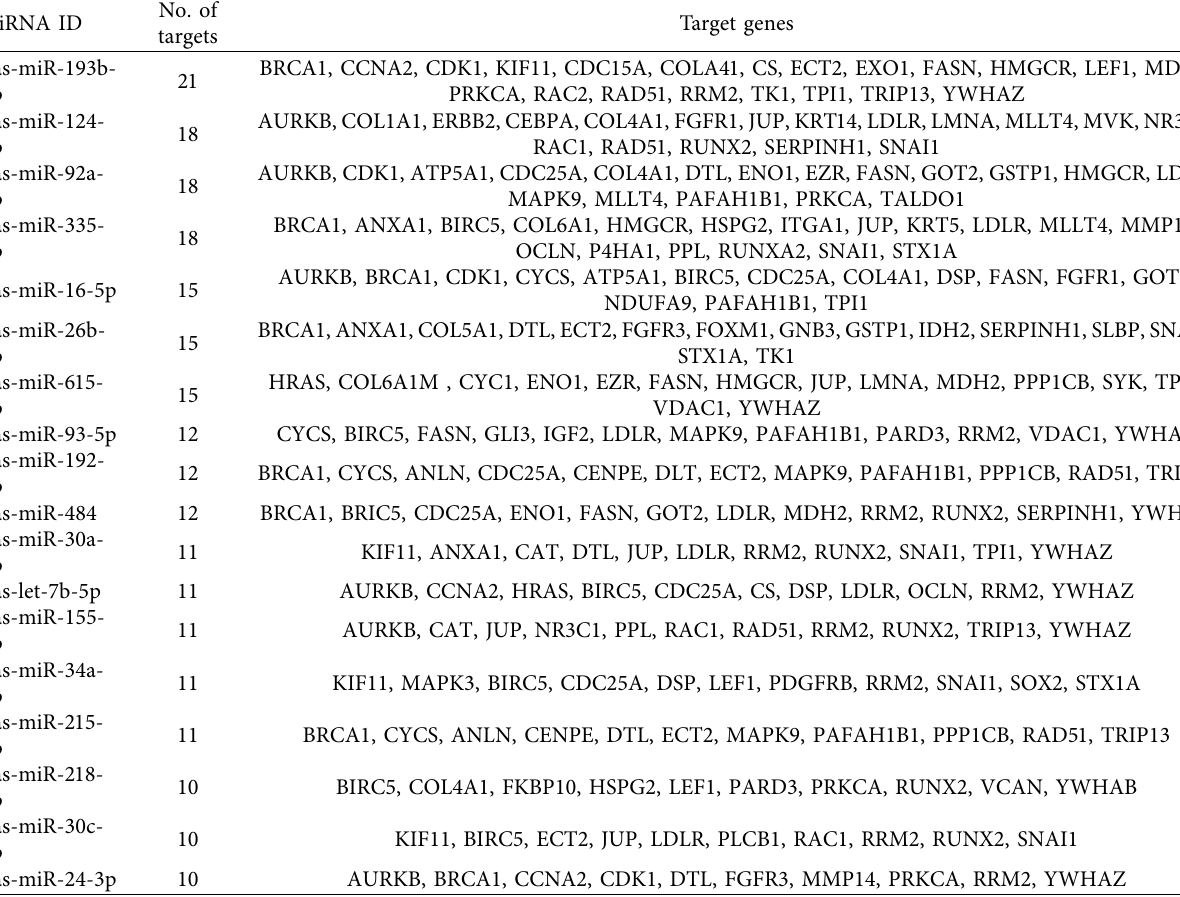
Table 3: A total of 18 miRNAs acting on the hub genes in primary